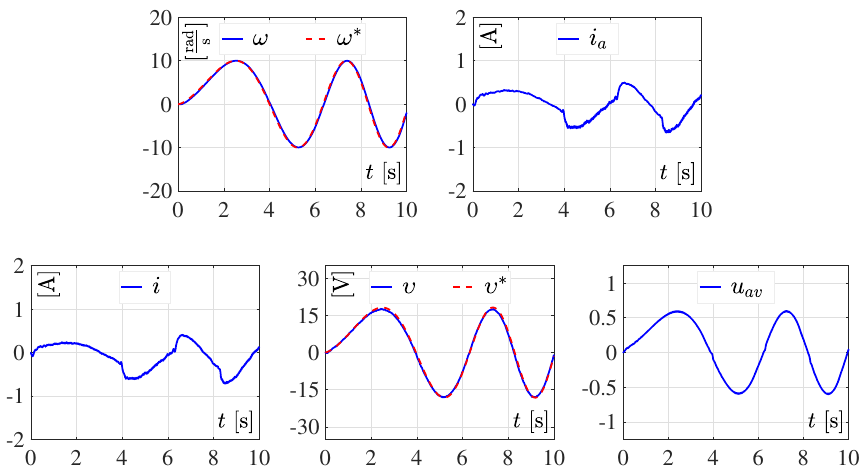
Figure 11. Experimental results of the system in closed-loop, when the fourth desired trajectory for ω ∗ , determined by (25), is taken into account.